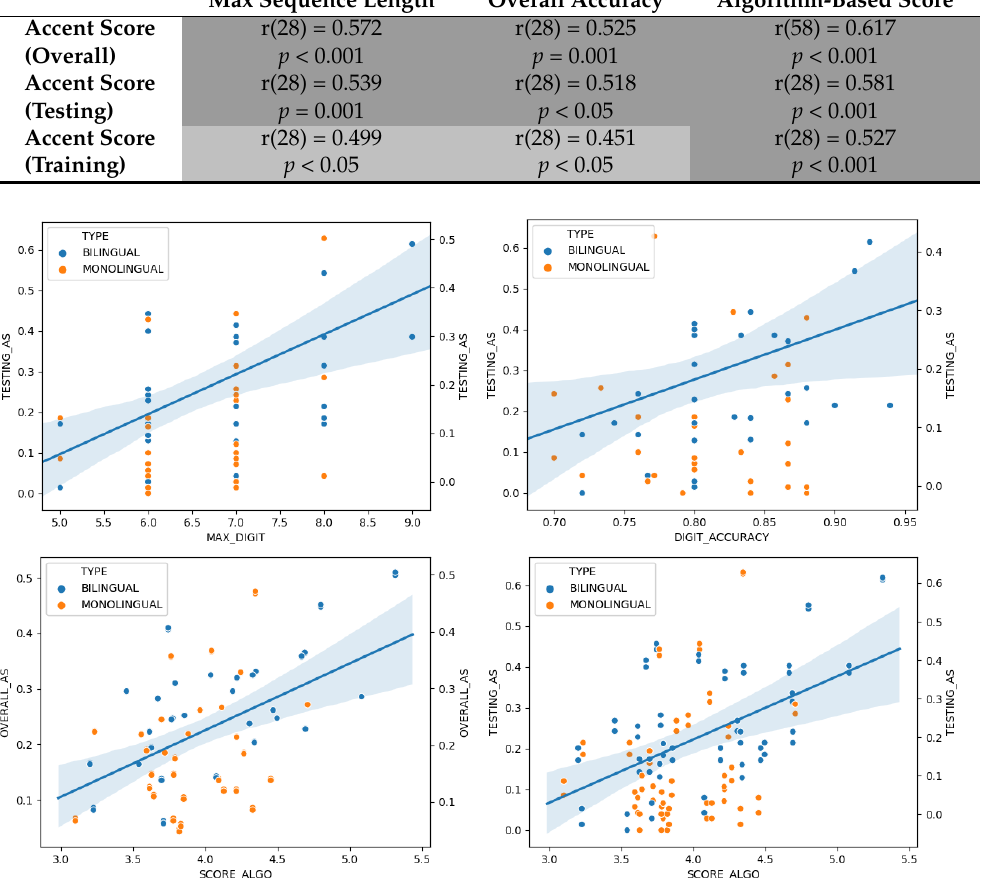
Table 3. Significant correlations between variables associated with phonetic and phonological learning (arranged vertically) and variables associated with auditory sensory memory (arranged horizontally) for the BILINGUAL group. Gray shading indicates the strength of the correlation (light gray = weak correlation, medium gray = moderate correlation, dark gray = strong correlation); n.s. = not significant. Max Sequence Length Overall Accuracy Algorithm-Based Score